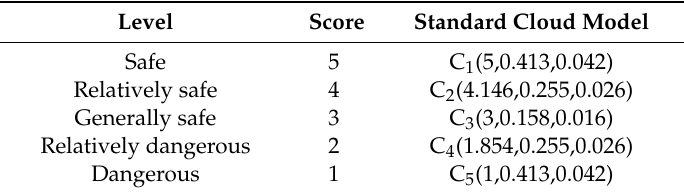
Table 2. Score and standard cloud model of safety evaluation